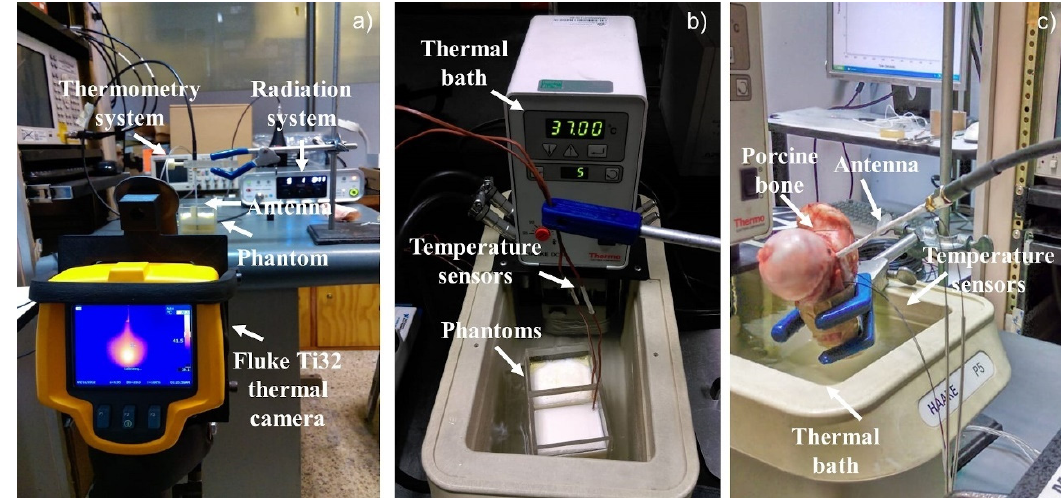
Figure 3. Experimental set-up used to record the temperature increase in the multilayer phantoms and the ex vivo porcine tissue. ( a ) Experimental set-up used to take the thermal distributions by the thermal camera, ( b ) Experimental set-up to perform the experimentation in a multilayer tissue phantom, ( c ) Experimental Set-up to perform the experimentation in ex vivo tissue.